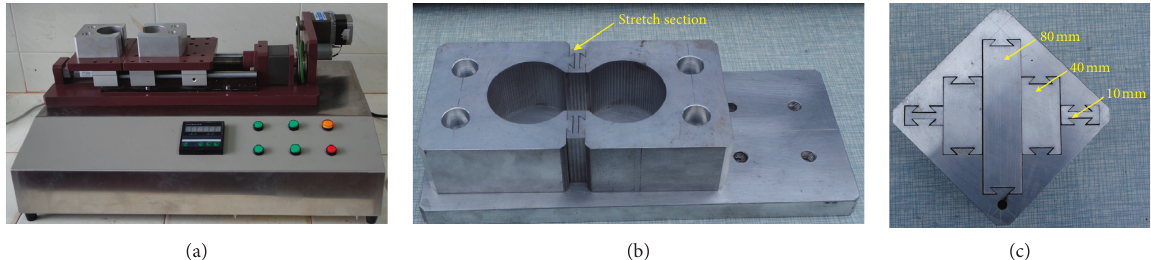
Figure 1: Tensile loading device and sample preparation mold: (a) tensile loading device; (b) sample preparation mold; (c) stretch section mold.